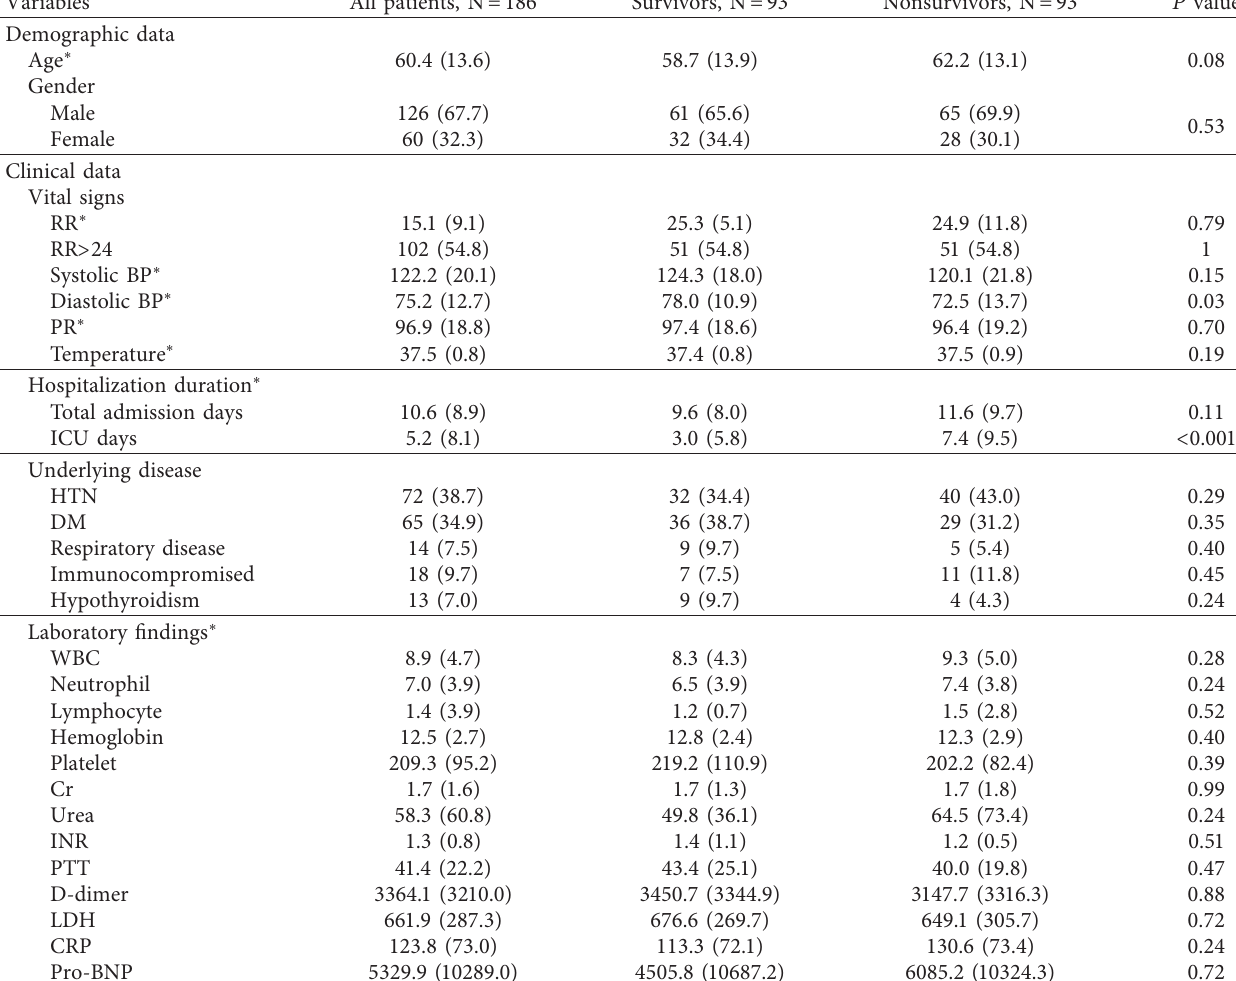
Table 1: Details of demographic and clinical data of patients and differences between two groups.